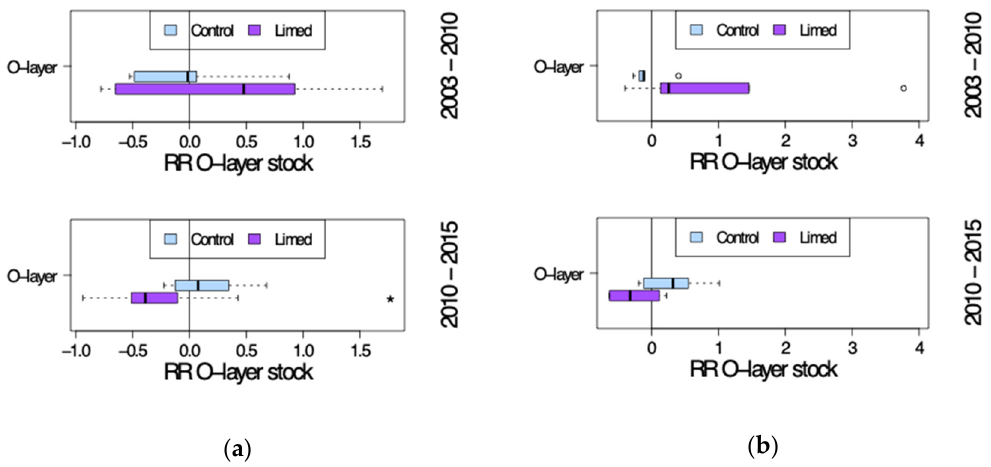
Figure 10. Organic layer stock site average response ratio (RR r ) seven years after (2003–2010) and twelve years after the second lime treatment (2010–2015). ( a ) G1 study sites and ( b ) G2 study sites. *—significant differences between current and previous sampling campaign.